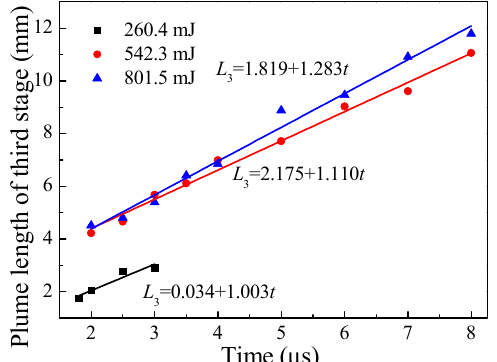
Figure 18. The plume length of third stage variation with time and its linear fitting at different laser energies (ambient pressure 0.005 Pa and 26.5% Al).